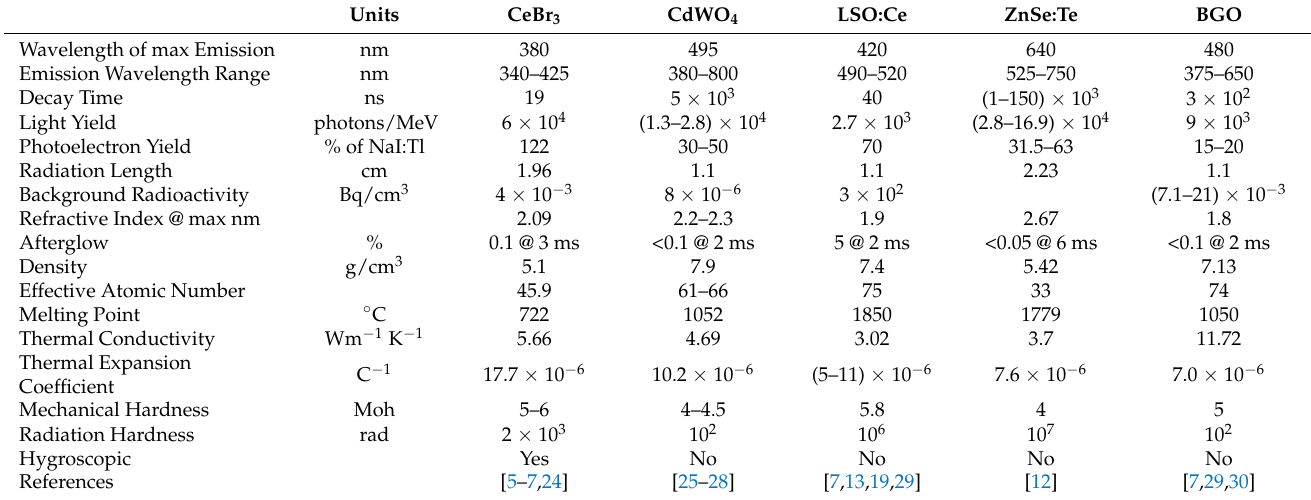
Table 1. Scintillators’